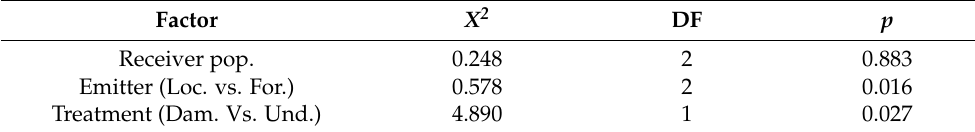
Table 2. Means ± SEs of individual compound emissions (ng/6 h/plant) averaged over three popu- lations of P. Lunatus (Flores, Inka, Yel) from three damage treatments , including an undamaged control. Only compounds that were found to be significantly different from the undamaged treat- ment are included. Bolded compounds indicate those that were significantly higher in the herbivore damage than mechanical damage treatment. Tukey HSD tests were used to assess pairwise signifi- cance.